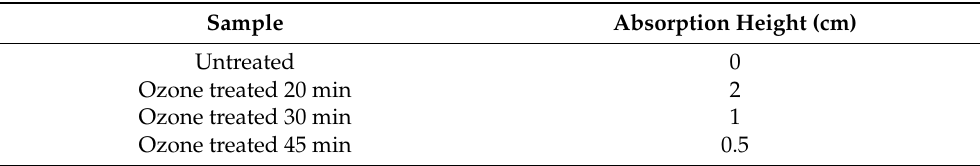
Table 2. Capillarity tests for polyester fabrics as a function of ozone treatment at different expo- sure